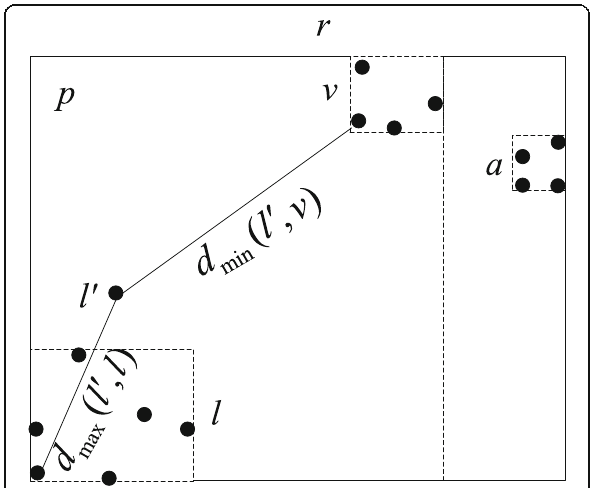
algorithm are as follows: